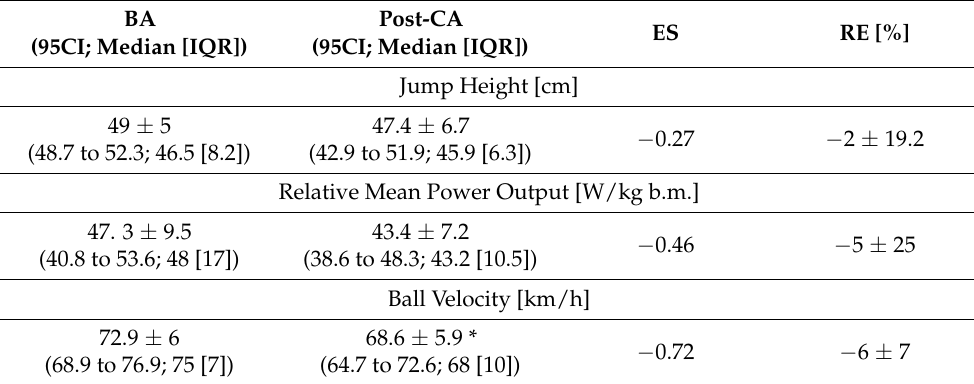
Table 2. Baseline and post-CA performance.